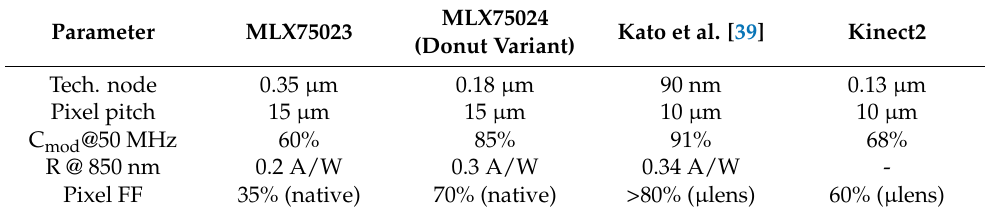
Table 1. CAPD performance